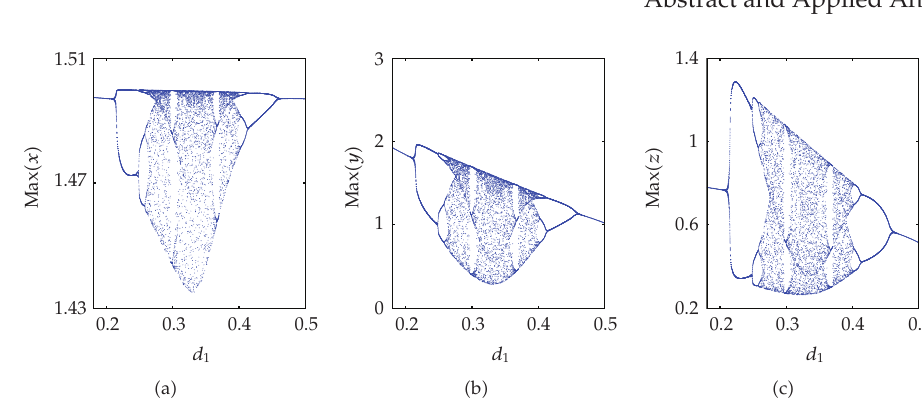
Figure 4: Bifurcation diagrams of system (cid:3) 1.2 (cid:6) with respect to d 1 : (cid:3) a (cid:6) maxima for the prey; (cid:3) b (cid:6) maxima for the mid-predator; (cid:3) c (cid:6) maxima for the top